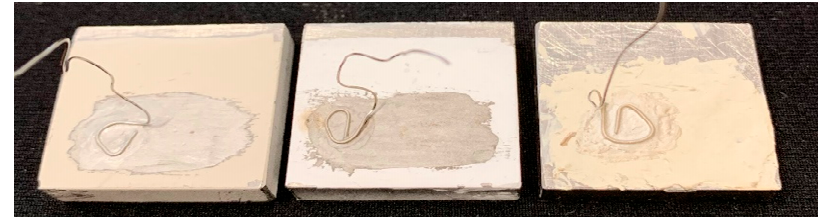
Figure 12. Bismuth titanate, lithium niobate, and organic bismuth titanate film transducers (left to right). Good adhesion was observed for extended periods of time. One film transducer is still working normally after several years of use. [7]